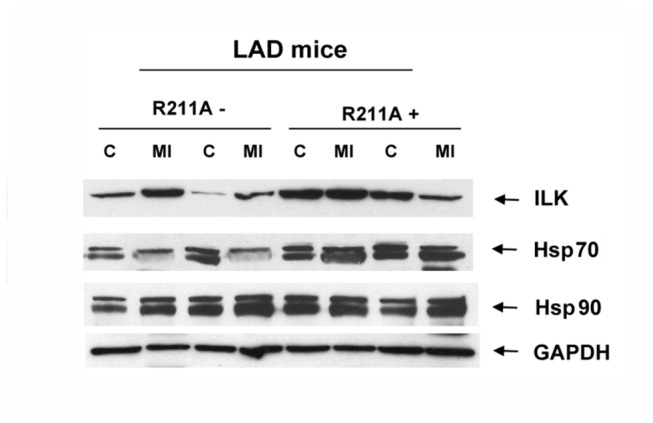
ILKR211A induces Hsp70 expression in the infarct zone of LAD-ligated mice.Western blot analysis of the protein levels of ILK, Hsp70 and Hsp90 in the lysates of myocardial infarct zone (MI) and control, viable, non infarcted myocardial zone (C) obtained from the hearts of two 28 days post LAD ligated TgR211A mice (+) and their littermate controls (-). GAPDH served as a loading control.